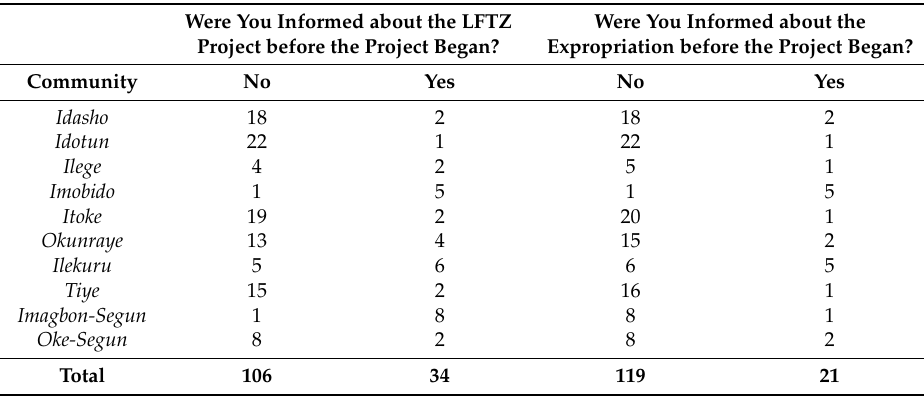
Table 7. Level of information given to each